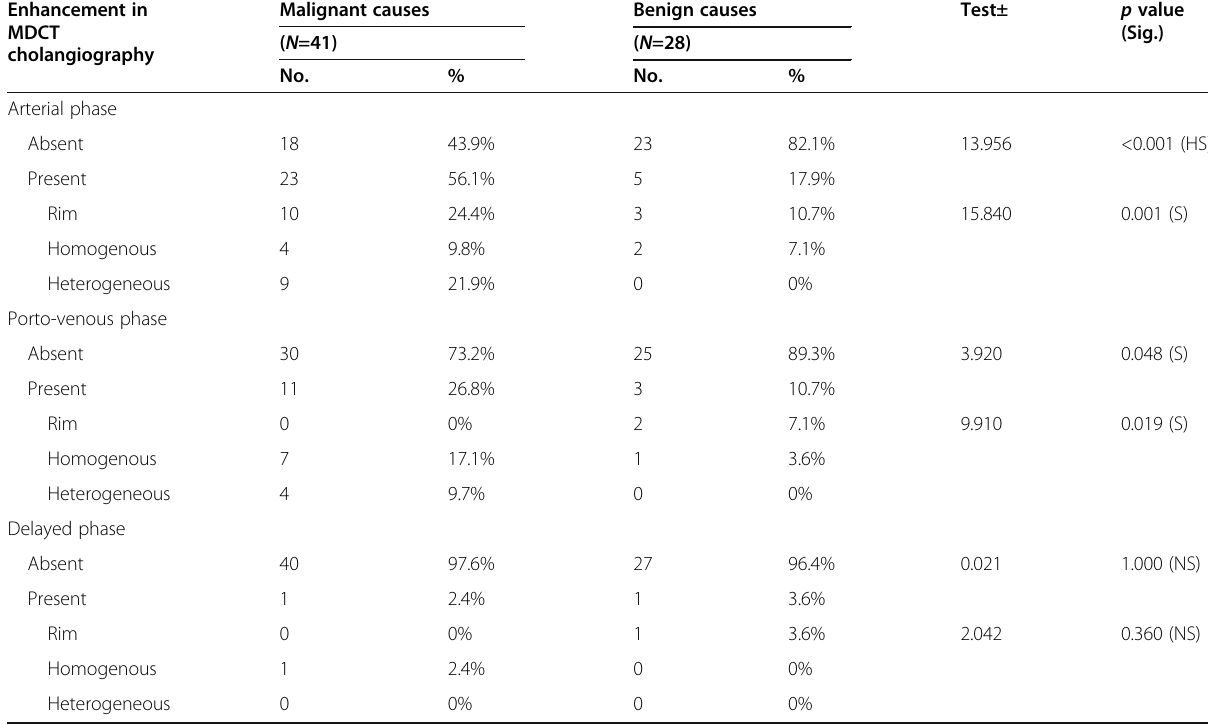
Table 4 Comparison between benign and malignant causes as regards post-contrast enhancement in MDCT cholangiography Enhancement in MDCT cholangiography